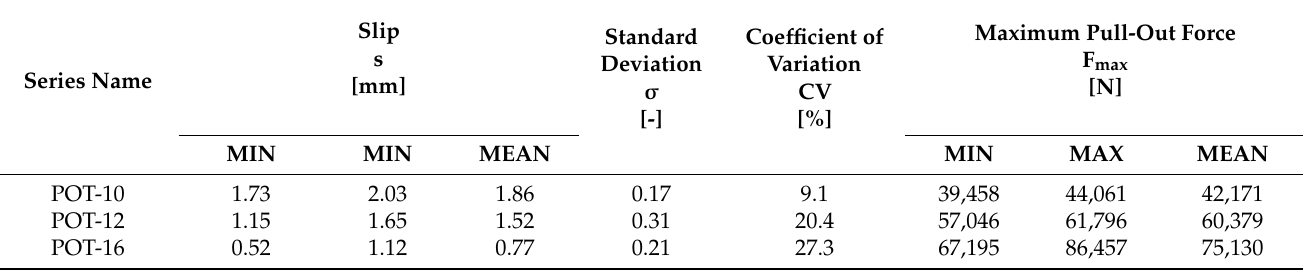
Table 11. Summary of slips and forces corresponding to maximum bond